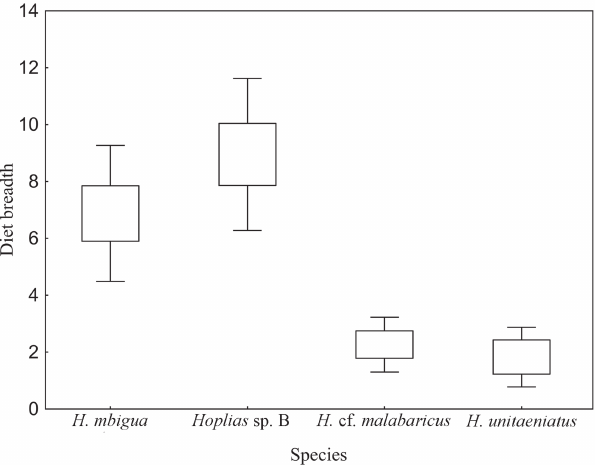
Fig. 2. Mean variation (vertical lines) in diet breadth (boxes) from non-native ( H. mbigua and H. unitaeniatus ) and native ( Hoplias sp. B and H. cf. malabaricus ) Erythrinidae species in the upper Paraná River floodplain based on 36 food categories.